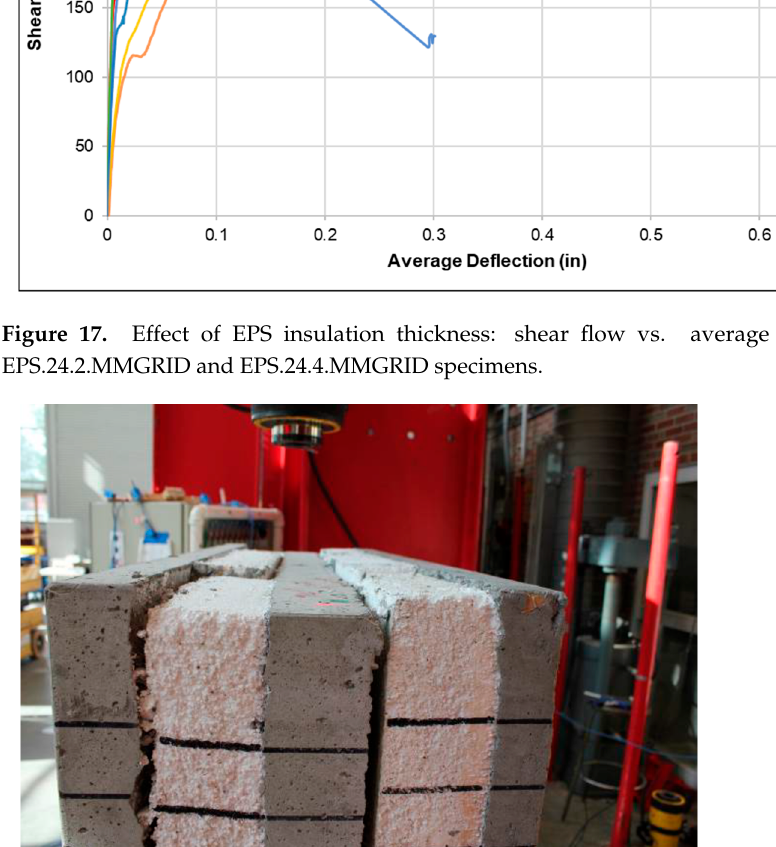
Figure 19. A failure showing substantial deformation in the foam prior to loss of bond. Figure 20. Typical view of combined rupture and pull-out failure mode.